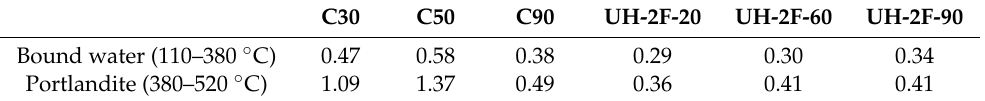
Table 2. TGA-determined bound water and portlandite contents (cement